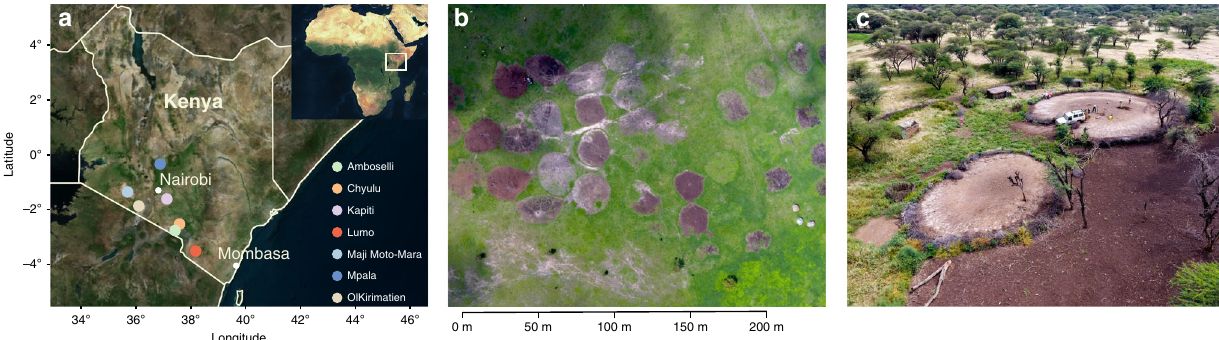
Fig. 1 Location of study sites and aerial photos of bomas. a Position of measuring locations across Kenya; b aerial picture of bomas at Kapiti Research Station; and c measurement of N 2 O fl uxes at boma sites at Ol Kirimatien Group Ranch in South-west Kenya.